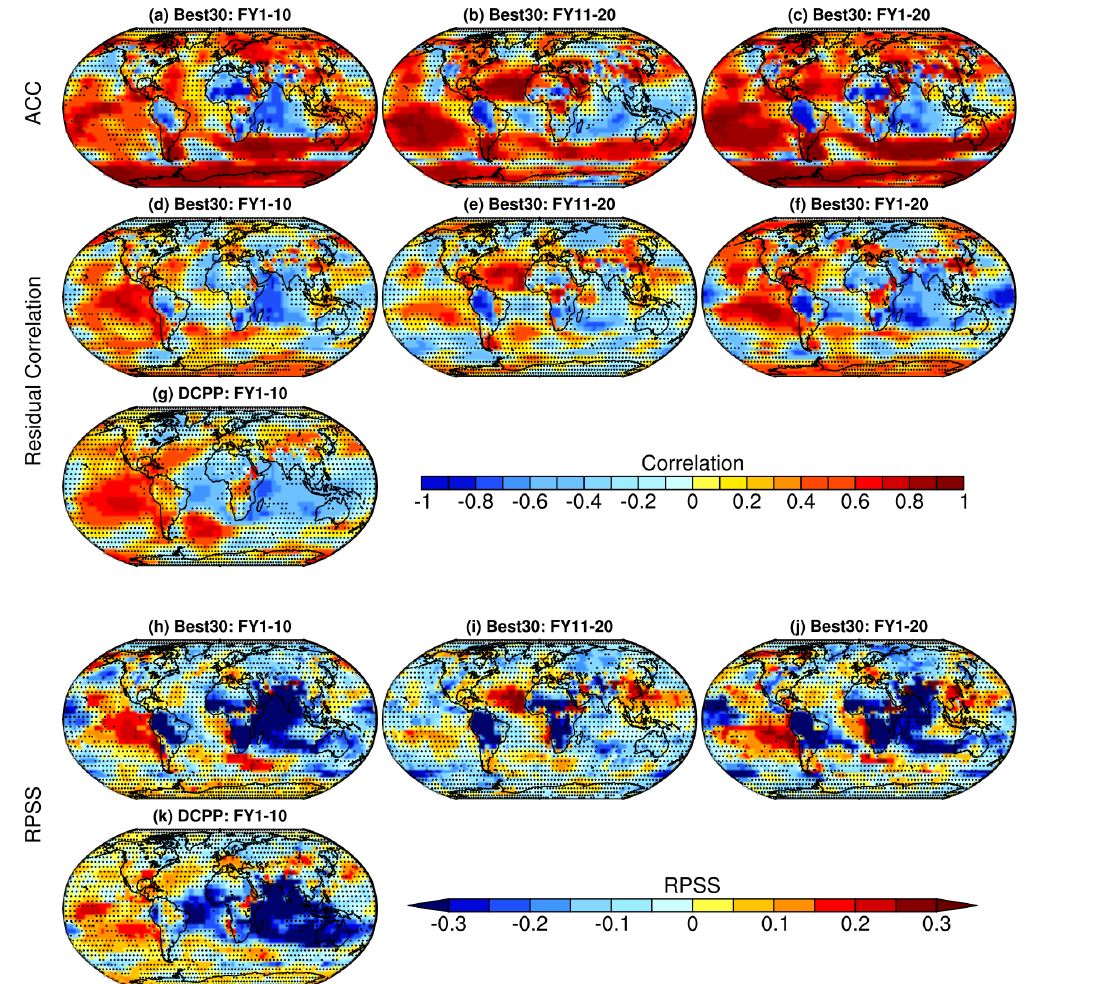
Figure 3. Anomaly correlation coefficient (ACC) between observed and predicted SLP anomalies for three forecast periods, average of forecast years 1–10, 11–20, and 1–20 (a–c) . Residual correlations for Best30 (d–f) and for DCPP (g) ensemble means after removing the forced signal (estimated based on ensemble mean of the unconstrained 212 members following Smith et al., 2019). RPSS for Best30 (h–j) and for DCPP (k) against the unconstrained CMIP6 ensemble as reference. Stippling indicates regions where the ACC, residual correlation, and RPSS are statistically not significant at 95% confidence level (see Methods for